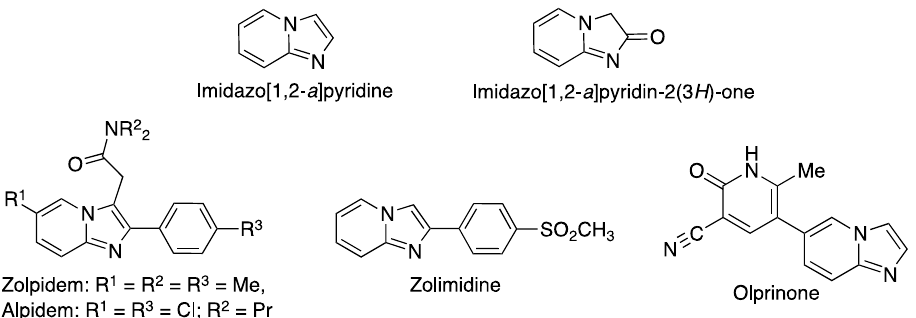
Figure 1. Structures of imidazo[1,2- a ]pyridine, imidazo[1,2- a ]pyridin-2(3 H )-one and some relevant imidazo[1,2- a ]pyridines.